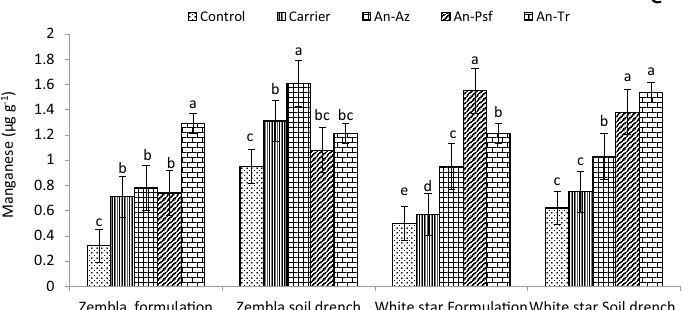
Figure 1: Influence of cyanobacterial biofilm formulations on the micronutrient content in soil. a. Zinc, b. Copper, c. Manganese. The treat- ments include- Control, Carrier, A . torulosa - Azotobacter sp . (An-Az) biofilm, Anabaena torulosa – Pseudomonas fluorescens (An-Psf) biofilm, and Anabaena torulosa – T . viride (An-Tr) biofilm, applied as dry formulation or soil drench. NS, Non-significant. Based on ANOVA, rankings are denoted as lower case alphabets, in the